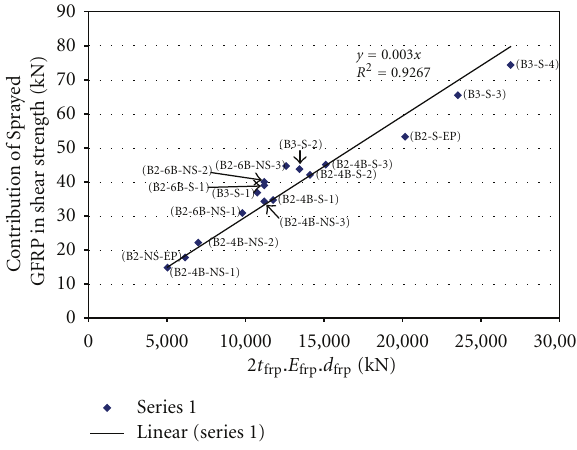
Figure 39: Contribution of Sprayed GFRP in shear strength versus 2 × t frp × E frp for RC beams strengthened by Sprayed GFRP on three sides, two sides with mechanical fasteners, and two sides with epoxy.